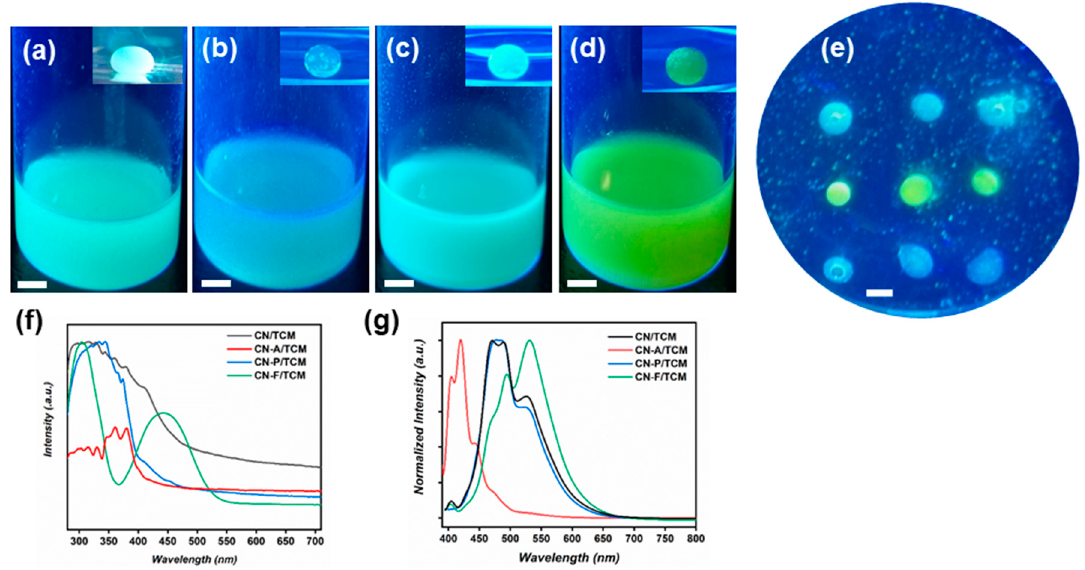
Figure 4. Series of digital images under UV ( a ) CMp-vTA / chloroform (CN / TCM) dispersion and corresponding droplet (inlet); ( b ) CMp-vTA + anthracene / chloroform (CN-A / TCM) dispersion and corresponding droplet (inlet); ( c ) CMp-vTA + pyrene / chloroform (CN-P / TCM) dispersion and corresponding droplet (inlet); ( d ) CMp-vTA + ferrocene / chloroform (CN-P / TCM) dispersion and corresponding droplet (inlet); ( e ) droplets from inlets of b (bottom), c (top) and d (middle) together. Scale bars correspond to 1 cm. ( f ) UV-Vis spectra of utilized dispersions and ( g ) emission spectra of utilized dispersions.